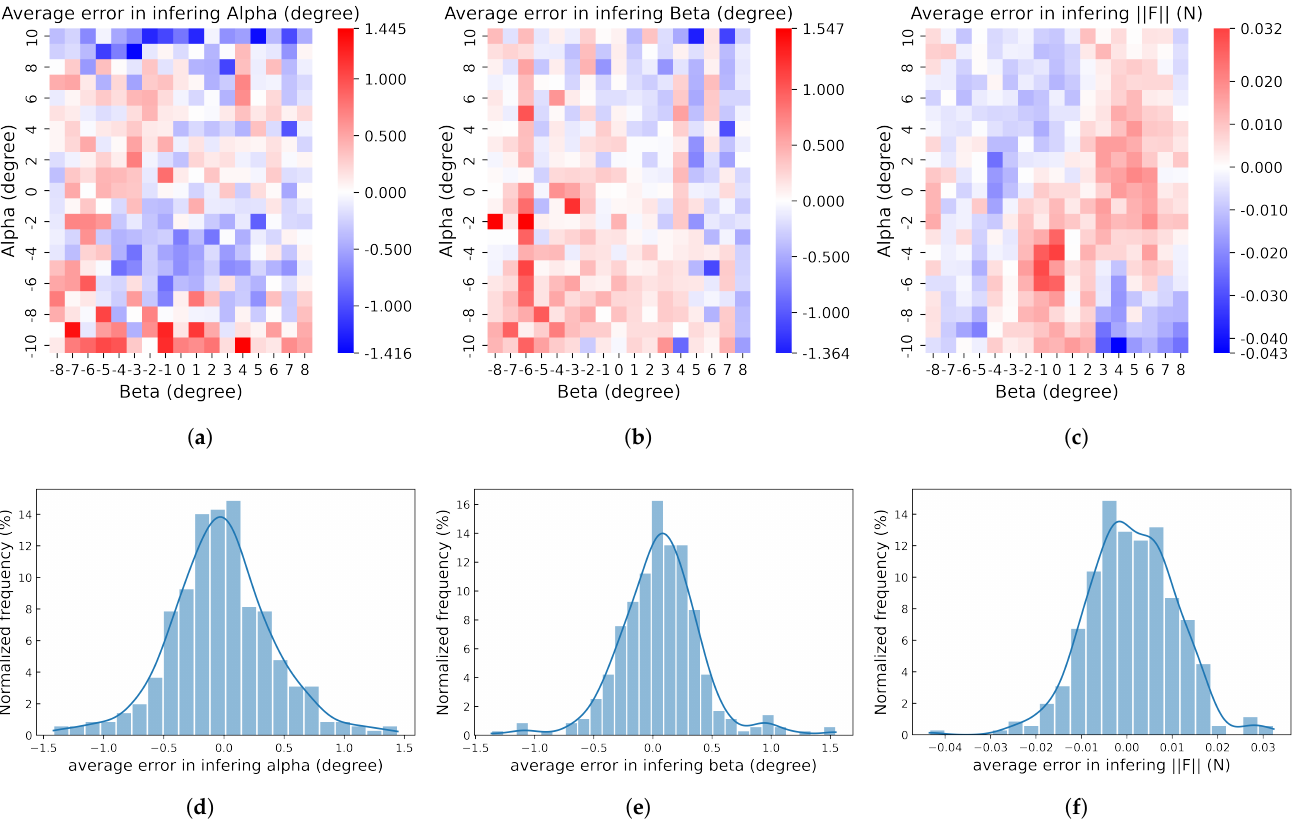
Figure 12. Average errors of ( a ) α , ( b ) β and ( c ) (cid:107) F (cid:107) on test set at each pose of proposed device, ( α , β ) , and corresponding frequency distributions ( d – f